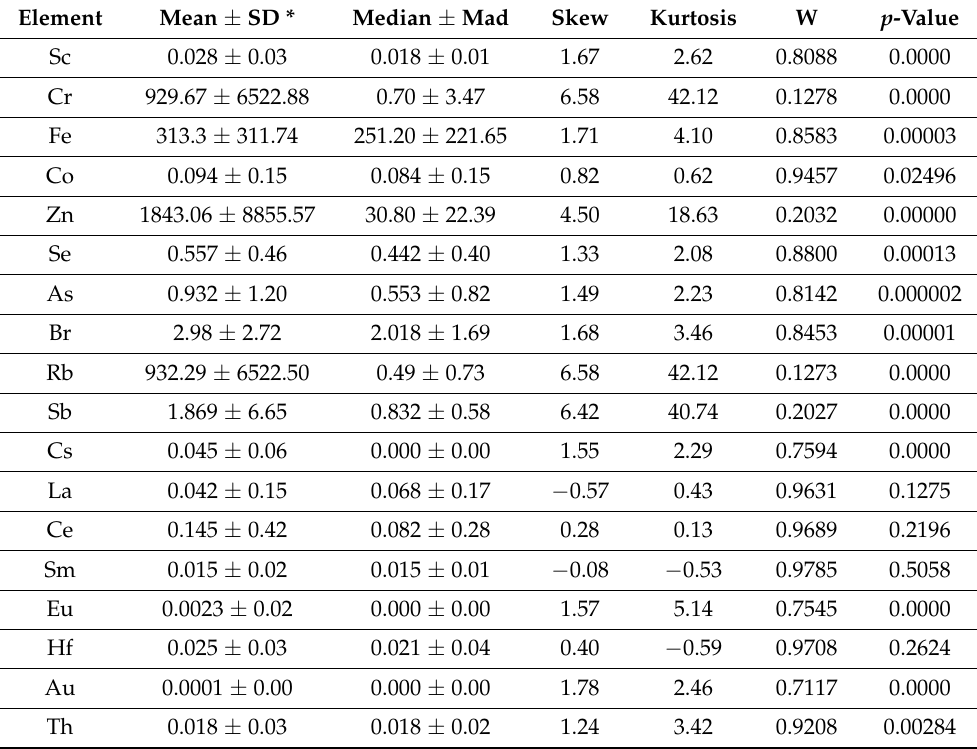
Table 2. Table 2. Descriptive statistics of the obtained mass fractions mg/kg, n =